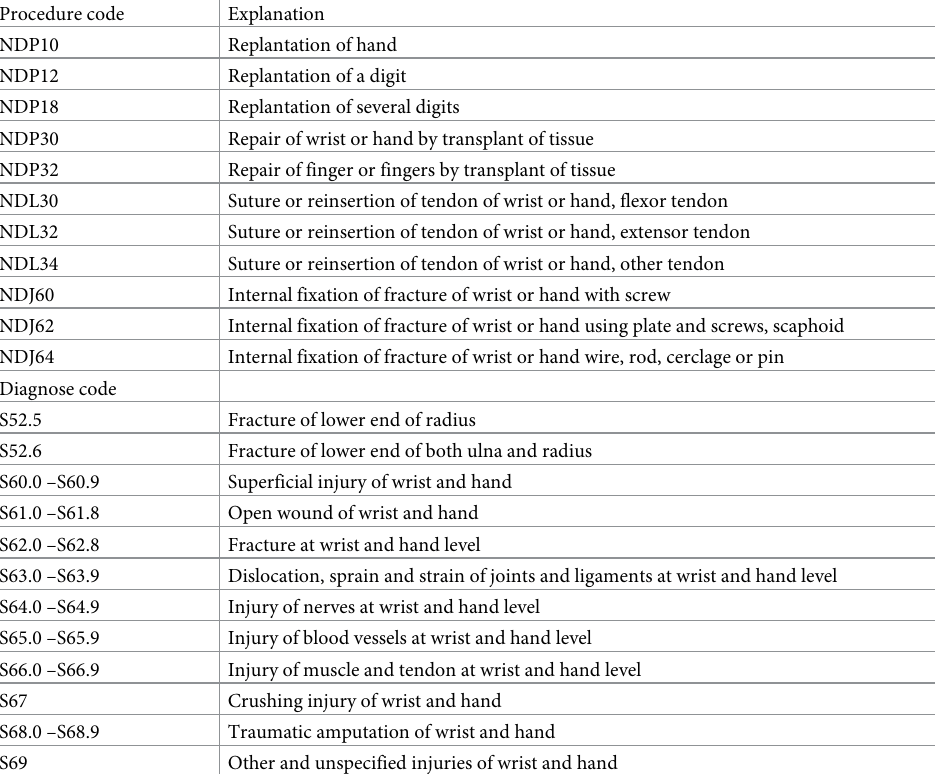
Table 1. Included operations based on the Nomesco surgical procedure classification and included diagnoses based on the international classification of diseases-10. Procedure